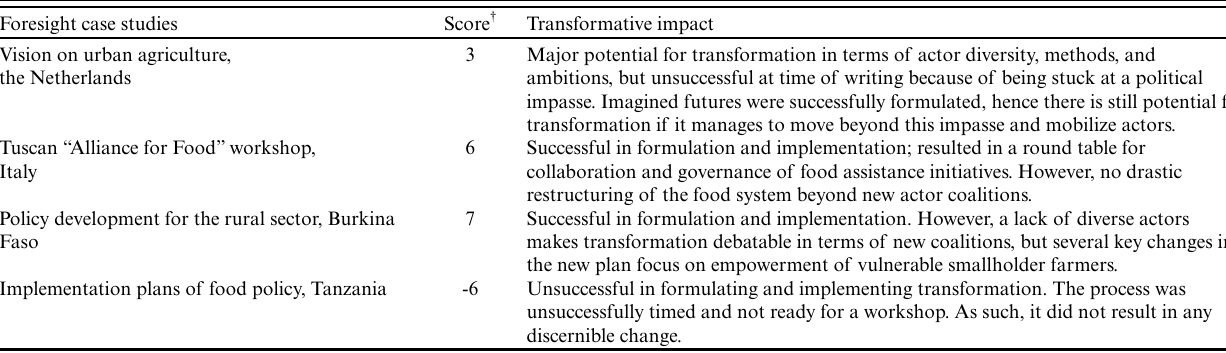
Table 4 . Scoring of achieved transformative impact, based on the scores appointed in Table